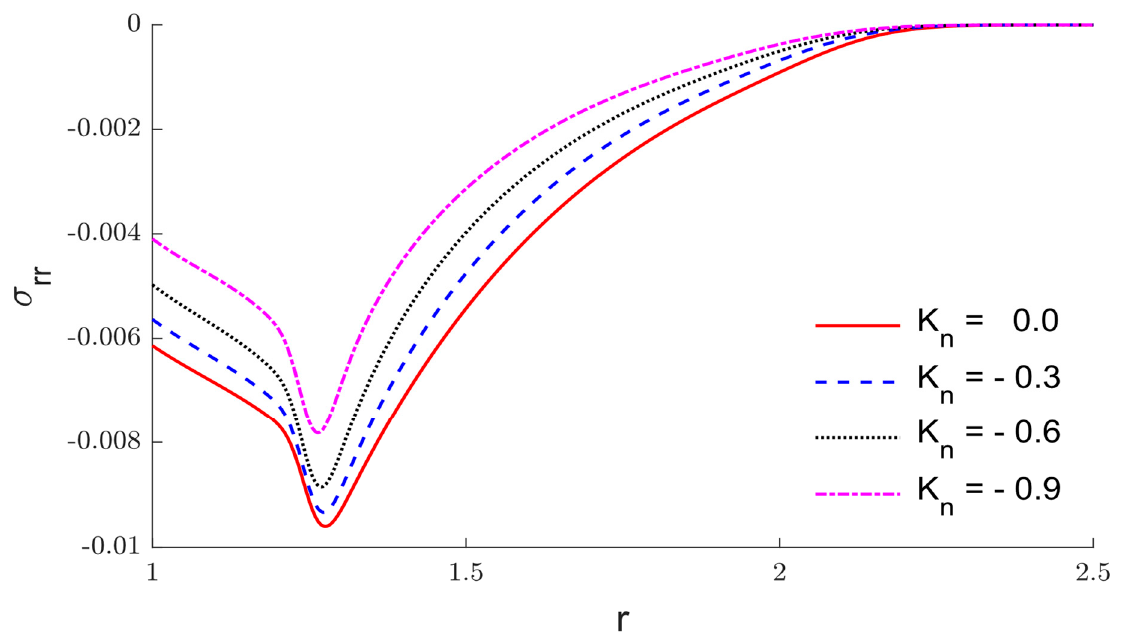
Figure 3. The variation of radial displacement 𝑢 via 𝑟 when 𝜏 (cid:3042) = 0.05 under varying thermal con- ductivity.